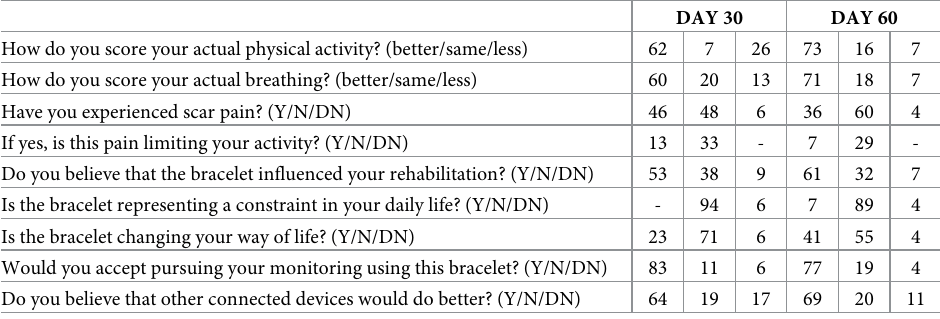
Table 4. Patient questionnaire at Day 30 and Day 60. Y = yes, N = no, and DN = don’t